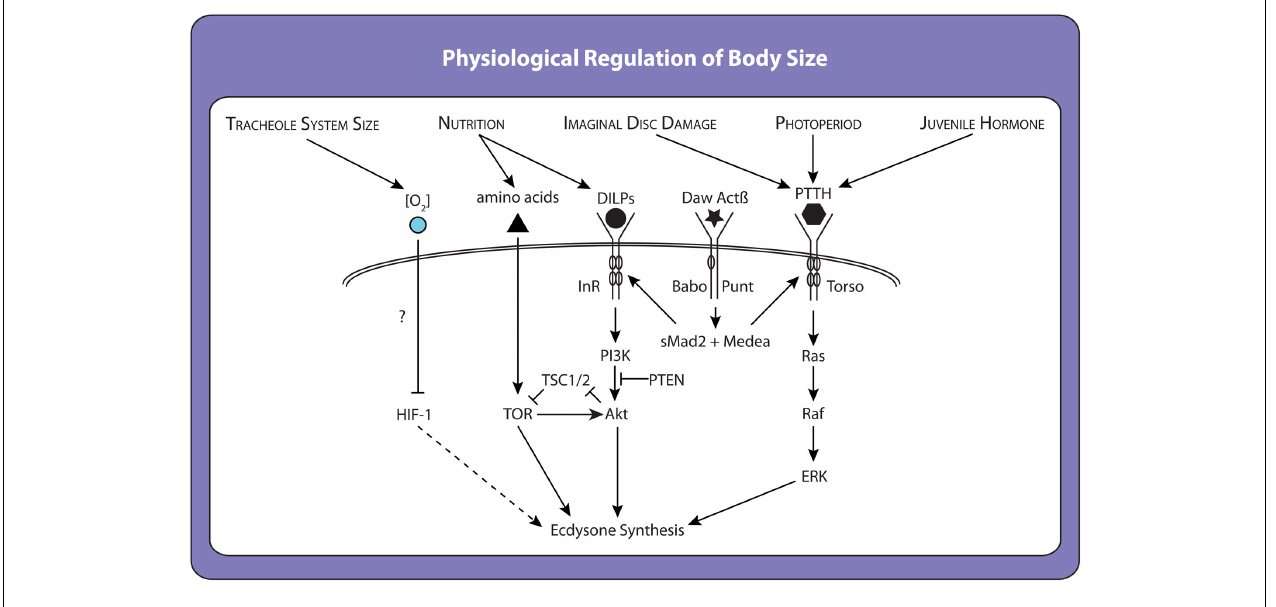
example, starving larvae before they reach critical weight causes a delay because the prothoracic gland must rely on other inputs to initiate ecdysone synthesis. However, once ecdysone synthesis has been initiated it is irreversible.Thus, critical weight represents a switch rather than the maintenance of a